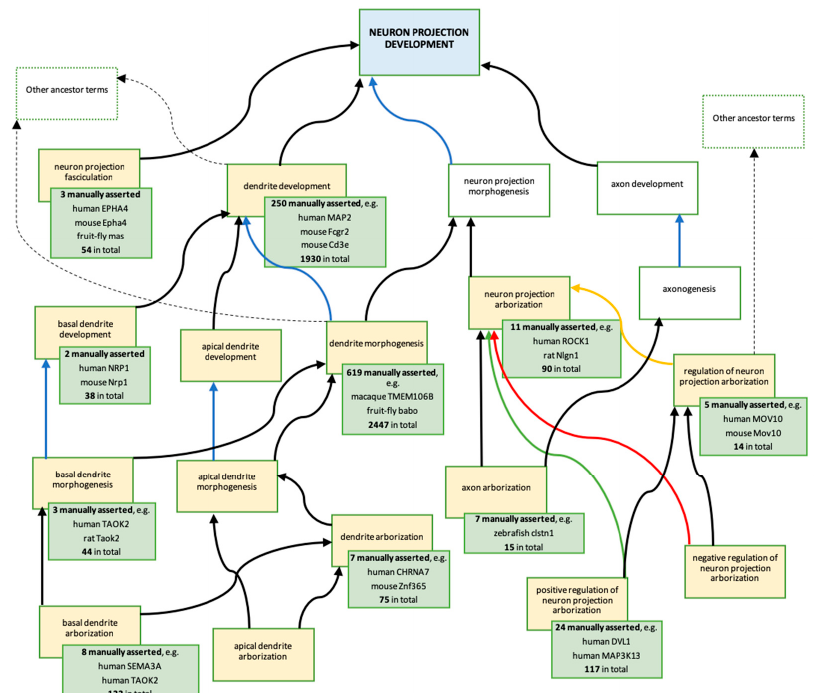
Figure 4. Descendants of biological process ‘neuron projection development’ GO term created or modified, as a result of this ARUK-UCL project. Ontology: The blue box represents the ancestor term ‘neuron projection development’ (GO:0031175). The yellow boxes represent the terms created, or modified, as a result of the ARUK-UCL project (Table S6); the majority of these are new terms; two terms were modified: ‘dendrite development’ (GO:0016358) and ‘dendrite morphogenesis’ (GO:0048813). The white boxes represent related terms in the ontology; no changes have been made to these terms. Arrows indicate the following ontology relationships: black—is_a, blue—part_of, yellow—regulates, green—positively_regulates, red—negatively_regulates. Annotations: Each green box provides information about gene products associated with the GO term in the yellow box, which it overlaps (data from QuickGO [51–53], accessed: 20 November 2018). For total numbers of